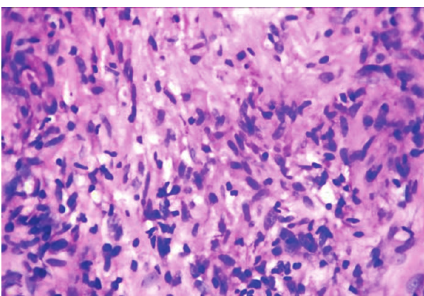
Figure 7: (Case 2): higher power view of epithelioid granuloma (H&E × 400).